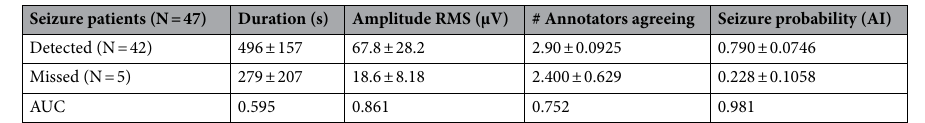
Table 2. Average ± CI95 for duration, amplitude RMS and average AI probability for correctly detected and missed seizures.